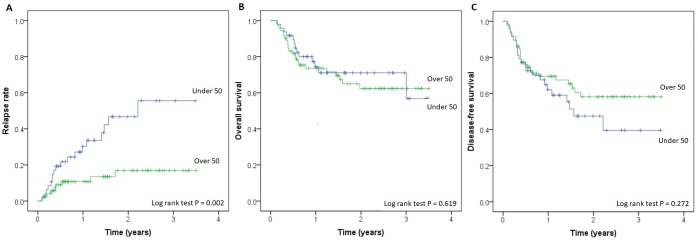
A) relapse-rate, B) overall survival and C) disease-free survival in study’s patients represented as Kaplan-Meier curves according to CD8+ T-cell status at one month.